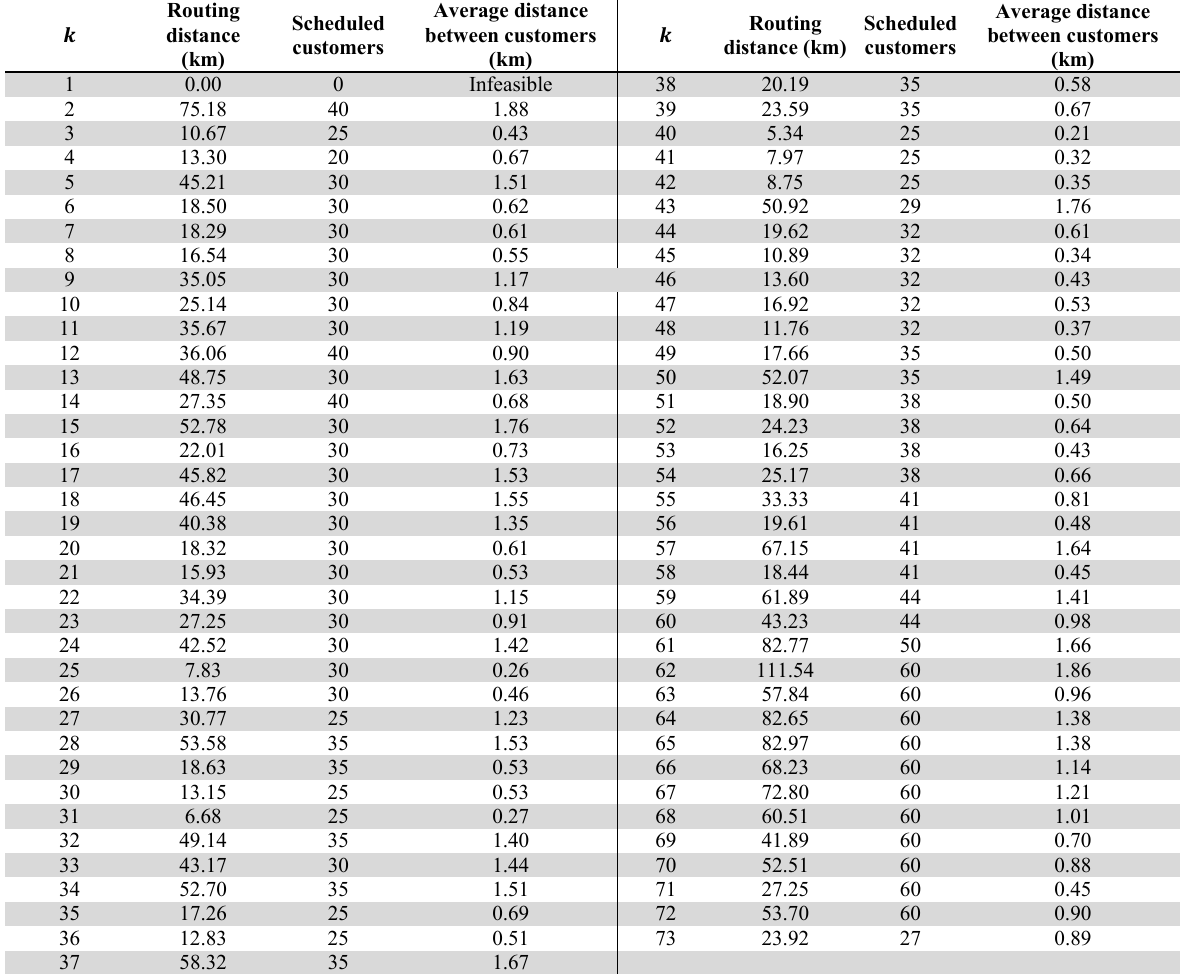
Results of ACO algorithm in routing phase for three days in the case